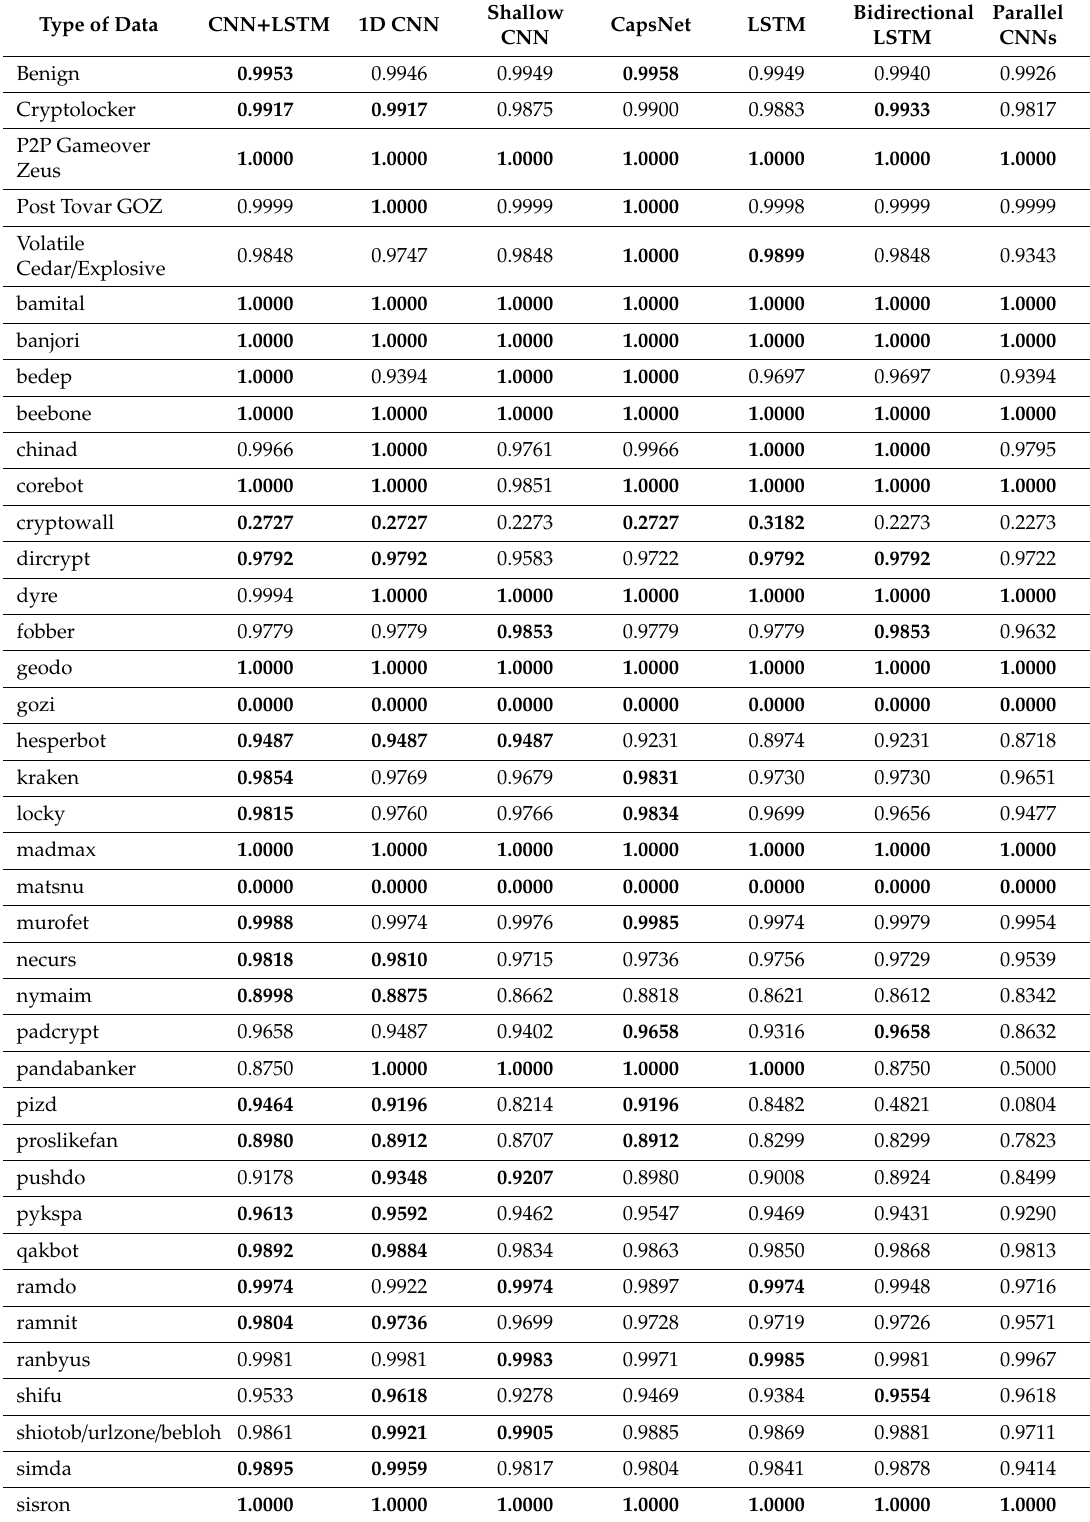
Table 5. Accuracy of random assignment experiment with the test dataset for benign and DGA